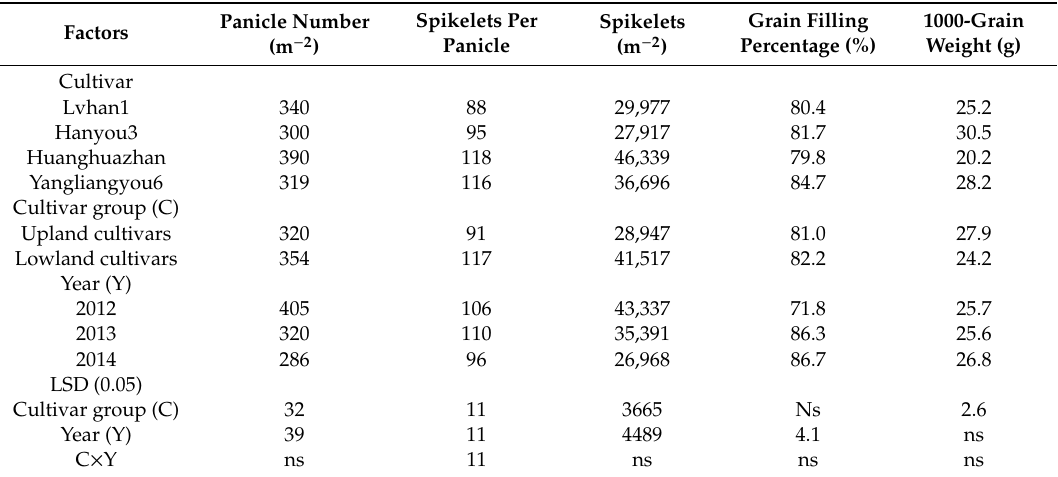
Table 4. Yield components of two cultivar groups including four rice cultivars under aerobic culture in all three